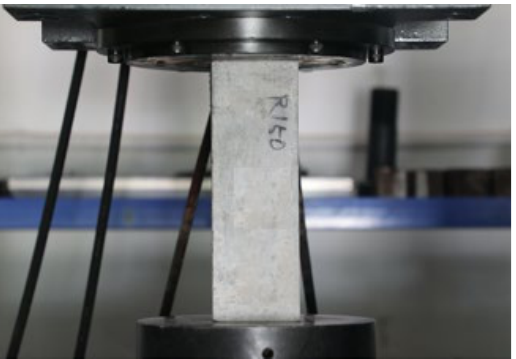
Figure 3. Quasi-static uniaxial compression test on the prismatic specimen.